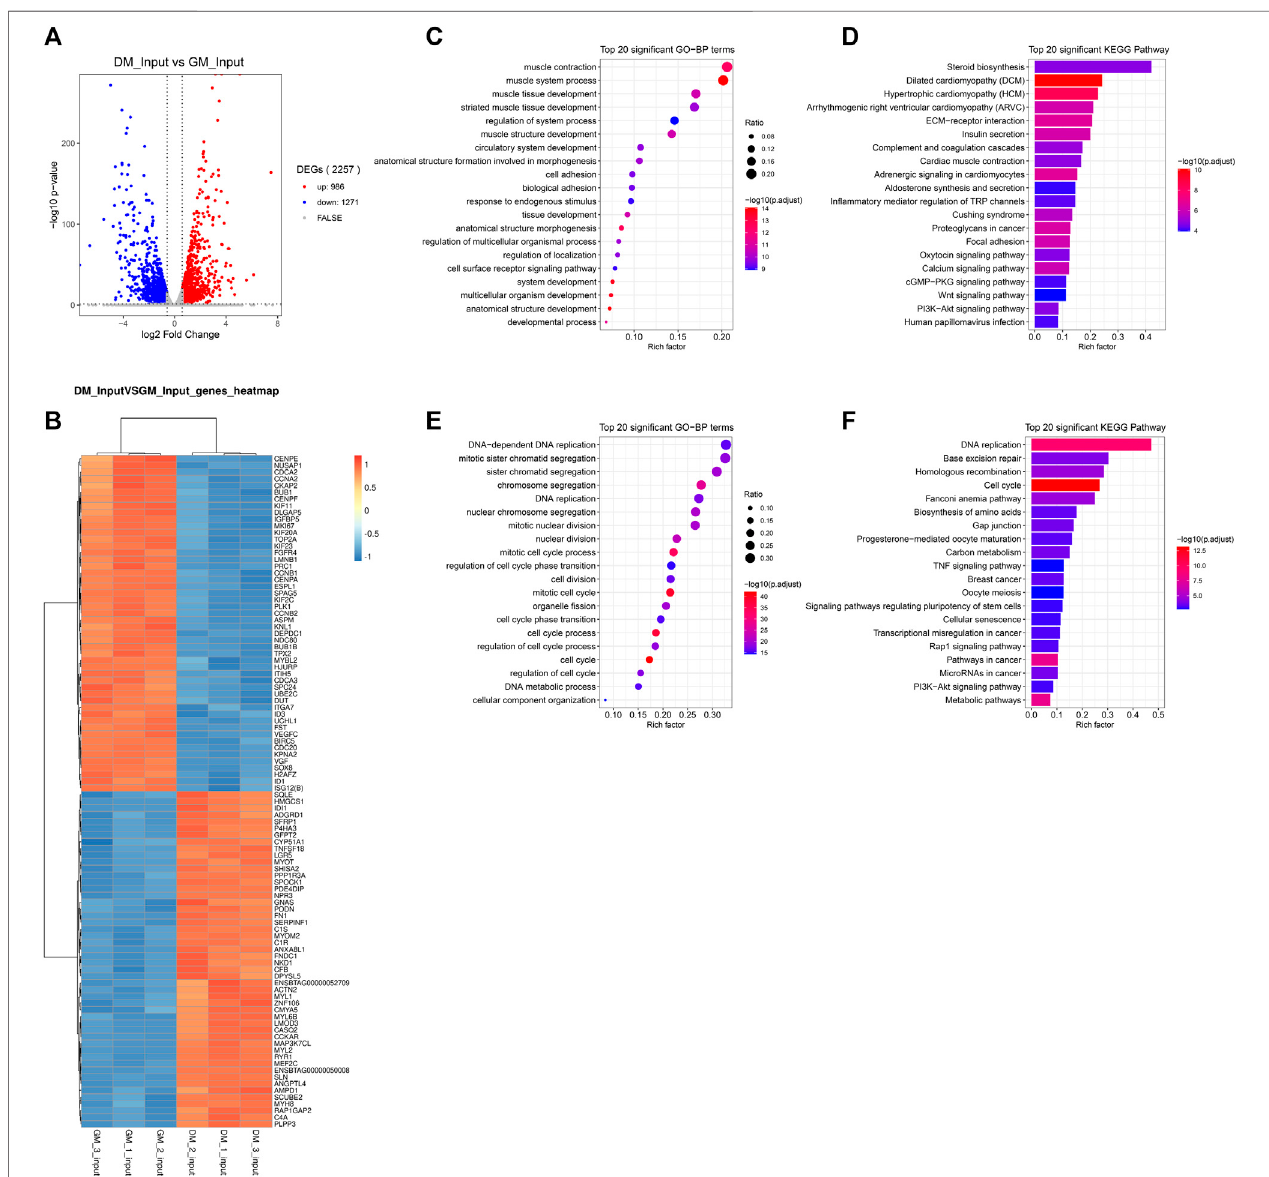
FIGURE 4 | Analysis of differentially expressed genes (DEGs) between bovine skeletal myoblasts and myotubes. (A) The Volcano plot of DEGs. (B) Hierarchical clustering heatmap of DEGs. (C) GO analysis of biological process for up-regulated DEGs. (D) KEGG analysis of up-regulated DEGs. (E) GO analysis of biological process for down-regulated DEGs. (F) KEGG analysis of down-regulated